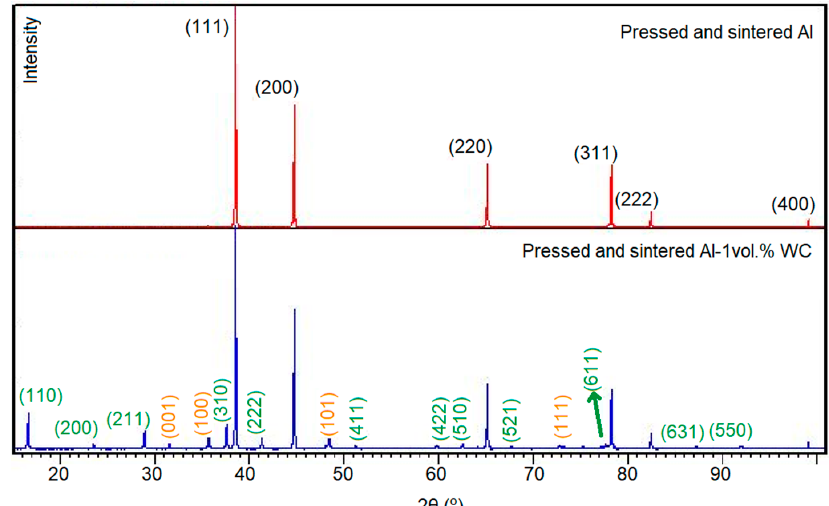
Figure 5. Diffractograms of sintered Al and Al-1 vol.% WC. The composite shows Al, Al 12 W and WC peaks. The Miller indices (hkl) of the diffraction peaks of Al, Al 12 W and WC are shown in black, green and brown, respectively.